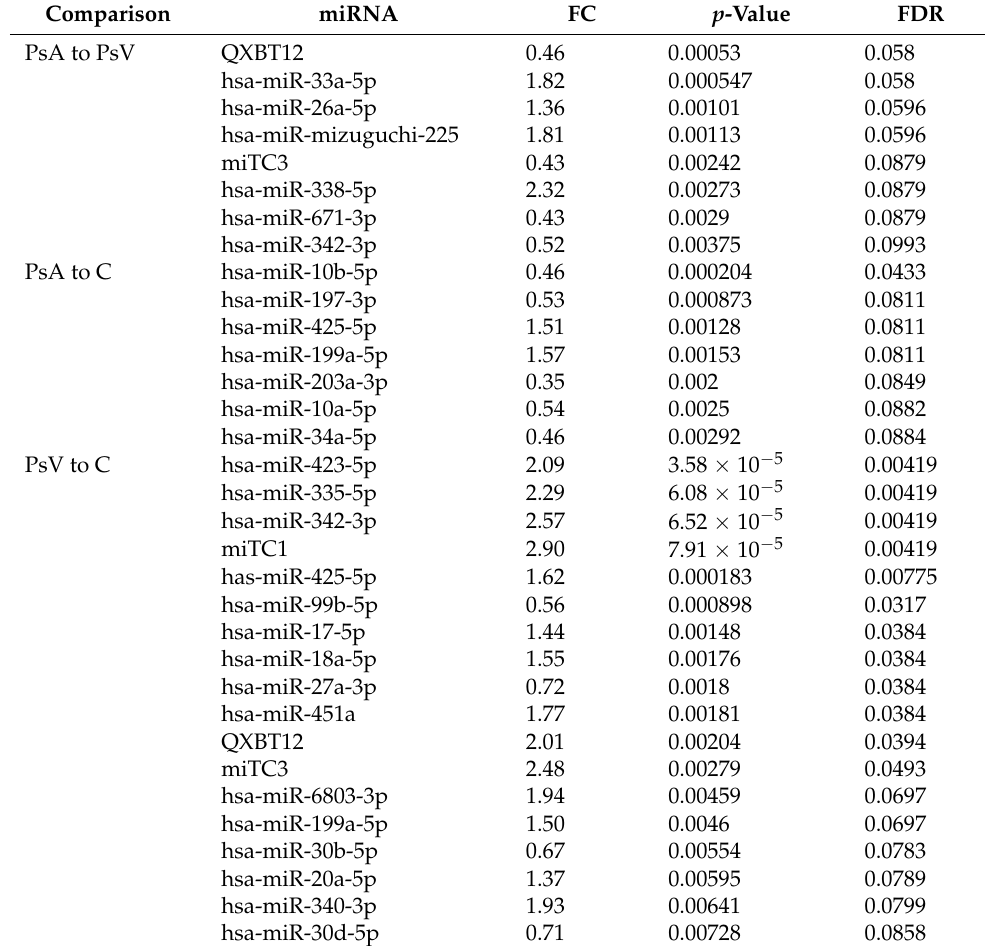
Table 1. Results of miRNA differential enrichment testing. Results are limited to FDR ≤